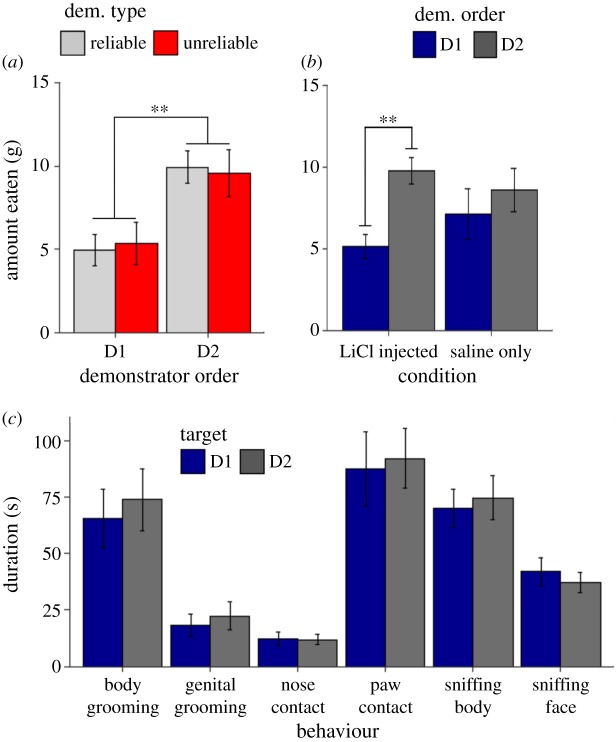
Relative recency of past STFP acquisition from a given demonstrator (i.e. demonstrator order) facilitates subsequent learning from that demonstrator. The average amount in grams (±s.e.m.) eaten of the demonstrated diets separated by (a) demonstrator reliability and order for observers in the LiCl-injected groups or (b) demonstrator order and injection condition. (c) The average duration in seconds (±s.e.m.) spent by observers socially attending to each demonstrator. We found no significant differences in observer-initiated social contact between the two demonstrators for any of the scored behaviours (**p < 0.01).